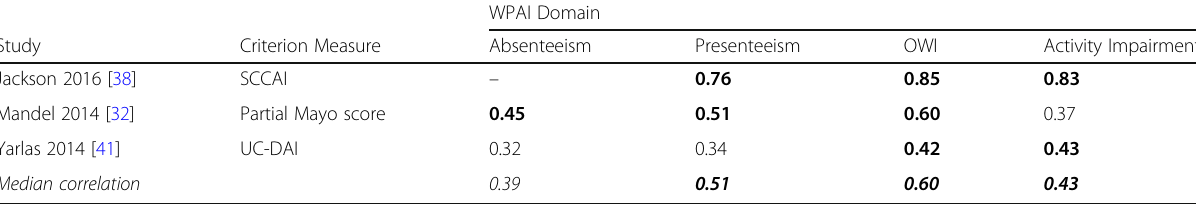
Table 4 Convergent validity: Correlations between WPAI domains and criterion measures of disease activity WPAI